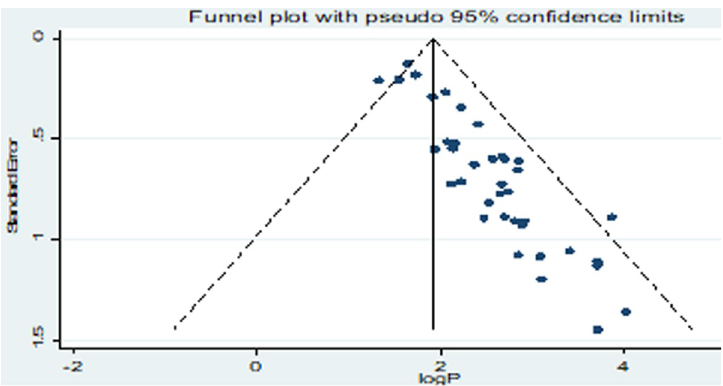
Fig 5. Funnel plot for the prevalence of Gram-negative enteric bacterial pathogens among diarrheic patients.